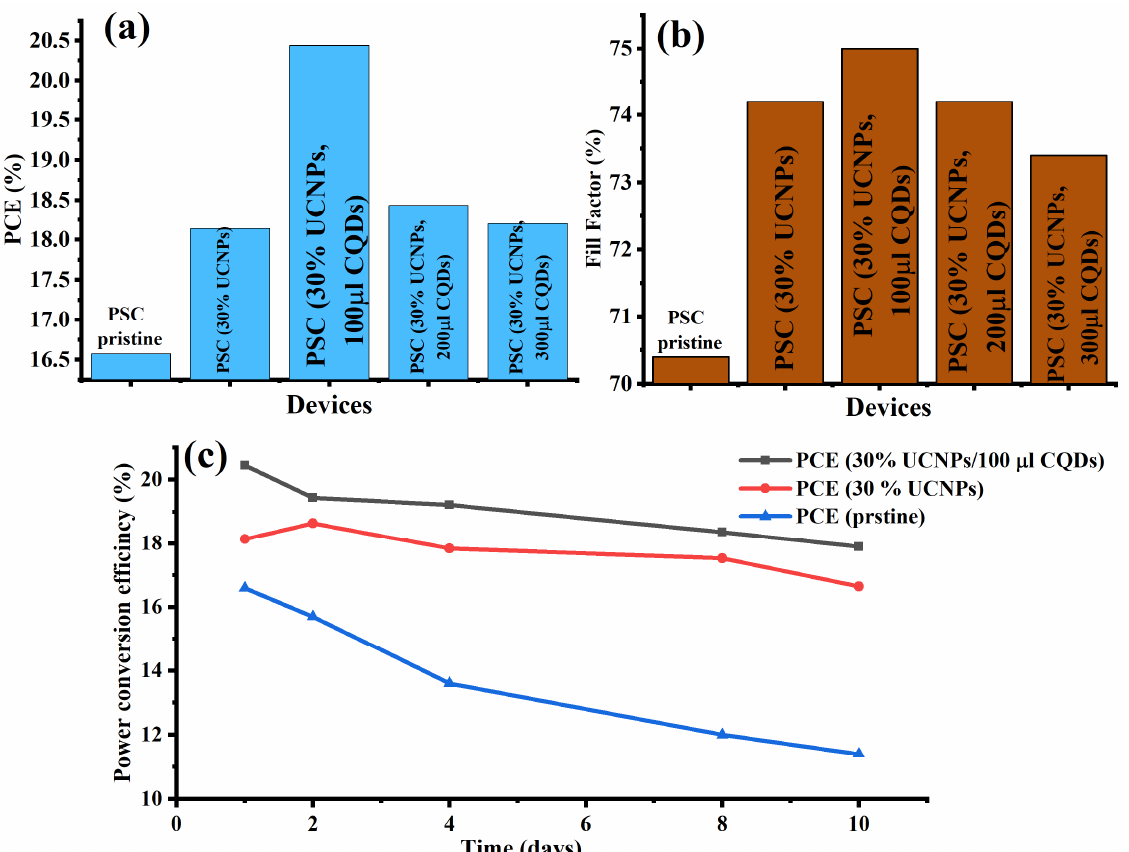
Figure 5. ( a ) PCE values of the synthesized PSCs in relation to the UCNP and CQD quantities integrated inside the mesoporous and perovskite layers. The enhancement of the constructed devices’ fill factor (FF) is shown in ( b ). ( c ) PCE values of the manufactured PSC devices with and without UCNPs and CQDs in ambient air for several days without regulating the humidity.